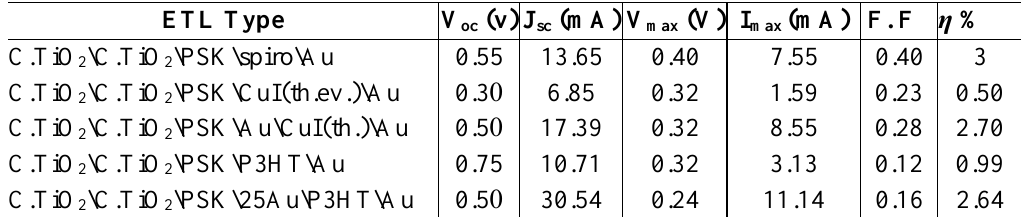
Table 2: Perovskite solar cell parameters measured with thin Au layer between HTL and